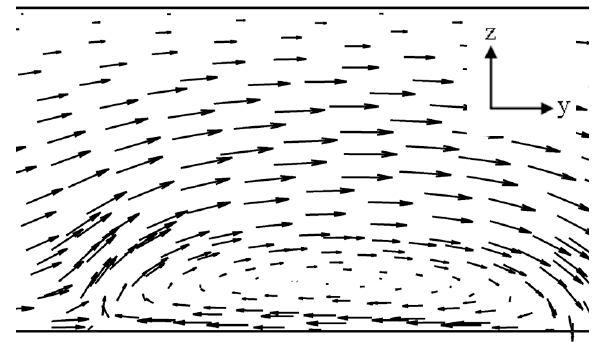
Figure 6. Vector plot at a y - z plane over a single heterogeneous patch.